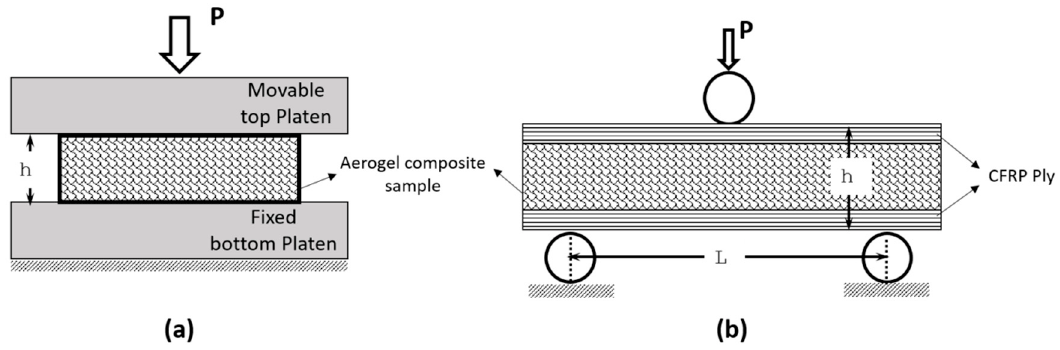
12 of 13 Table 5. Geometric parameters of fabricated aerogel composites. Sample*